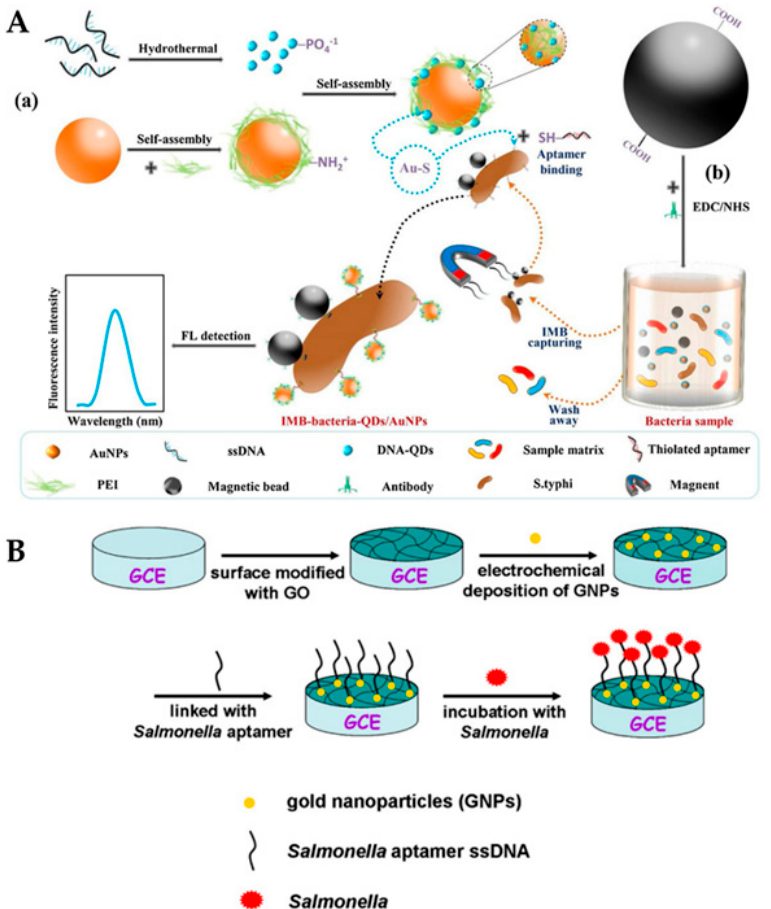
Figure 3. Nanomaterials (quantum dots and gold nanoparticles) for sensing. ( A ): ( a ) AuNPs and DNA-QDs for a self-assembled core–shell fluorescent probe. ( b ) Salmonella typhimurium was captured and enriched followed by isolation using magnetite microspheres. The attachment of surface-bound antibodies to the target bacteria and its reaction with the probe trailed by fluorescence measurements. Adapted with permission from Ref. [54]. Copyright 2020, Elsevier. ( B ): Detection of Salmonella using glassy carbon electrode (GCE). Graphene oxide was immobilized on the surface of GCE followed by electrodeposition of gold nanoparticles. Then, AuNPs were linked with ssDNA aptamers to capture the target Salmonella antigen. Adapted with permission from Ref. [70]. Copyright 2014, Elsevier.